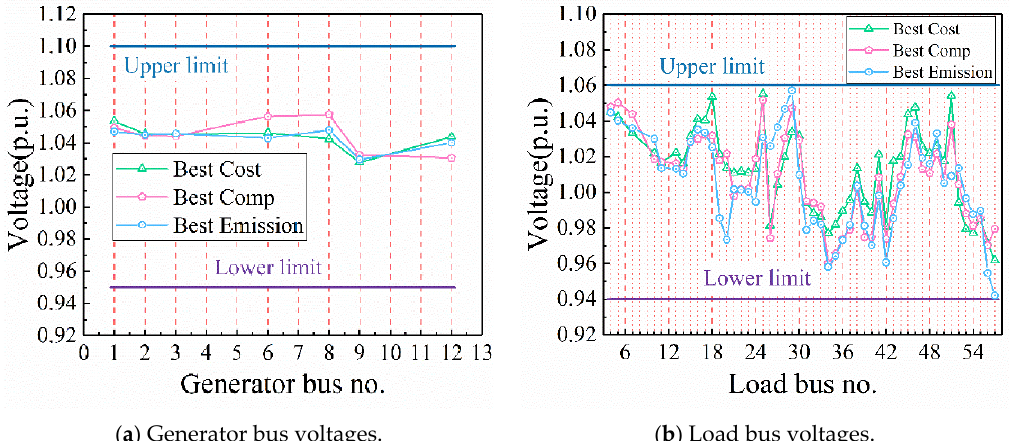
Figure 9. The bus voltages in the three solution scenarios obtained by CMODE for case 1.